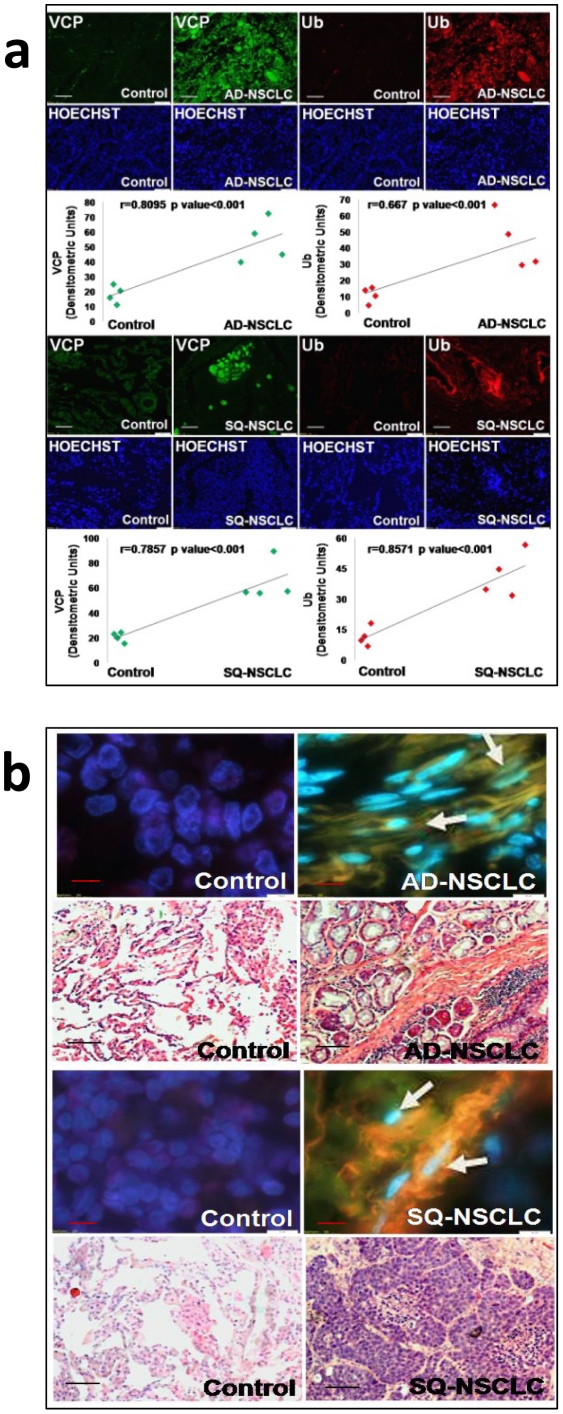
Elevated VCP protein levels and proteostasis-imbalance in NSCLC.(a) We examined the expression of VCP in adeno(AD)- and squamous(SQ)-NSCLSC as compared to normal tissue and observed a significant increase (p<0.001) in VCP expression and ubiquitin accumulation in both NSCLCs (n = 4, White bar = 100 µm). (b) We confirmed that VCP and ubiquitinated proteins are co-localized in peri-nuclear aggregates of these tissues (n = 4, Black bar = 100 µm & Red bar = 10 µm). Elevated VCP protein expression and ubiquitin accumulation in NSCLC indicates proteostasis-imbalance.